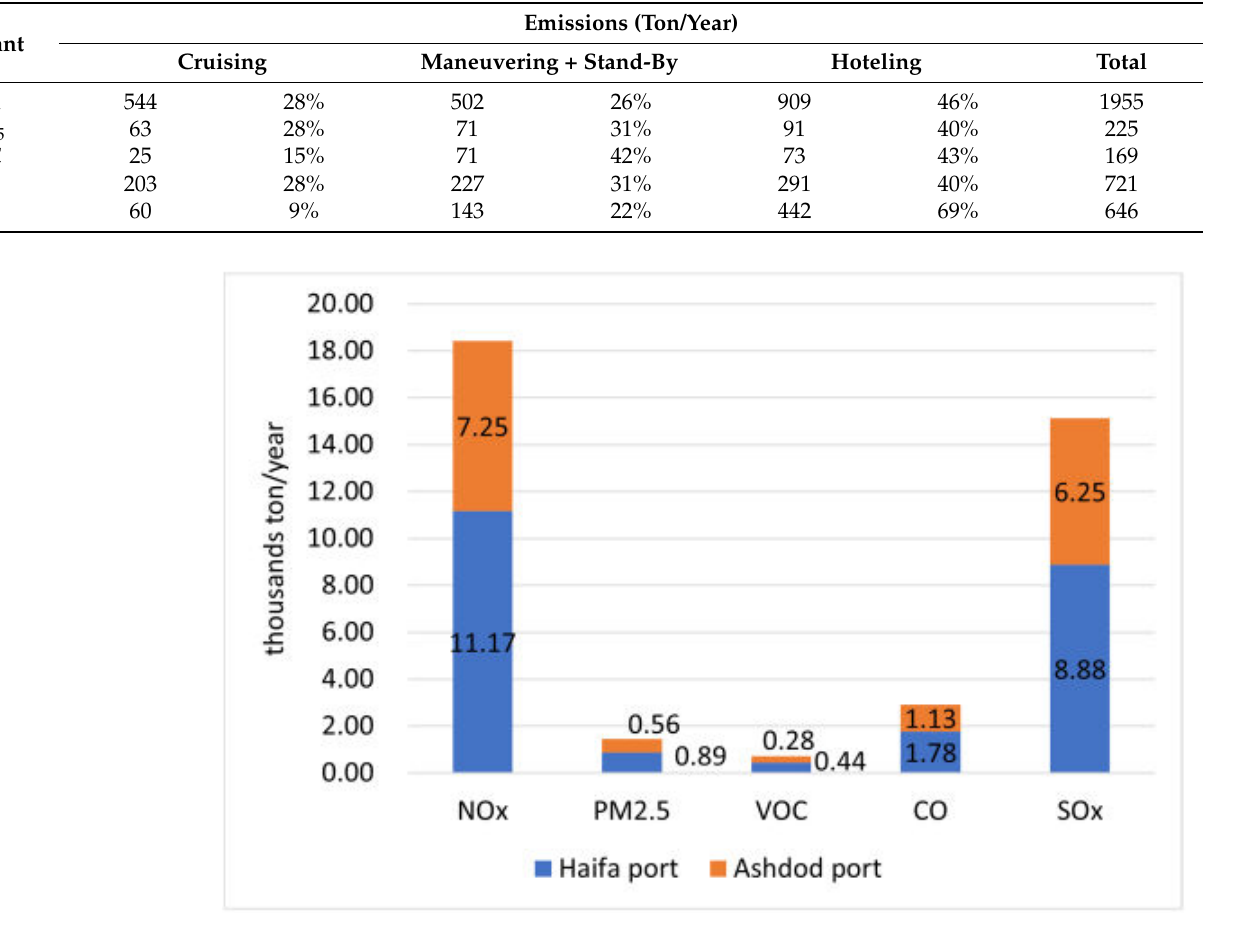
Figure A2. Calculated present (2018) annual emissions of air pollutants from the ship sector in Haifa and Ashdod ports. Y axis is ton pollutant per year. All values are based on marine port activities data for the year 2018. See Tables A9 and A18.